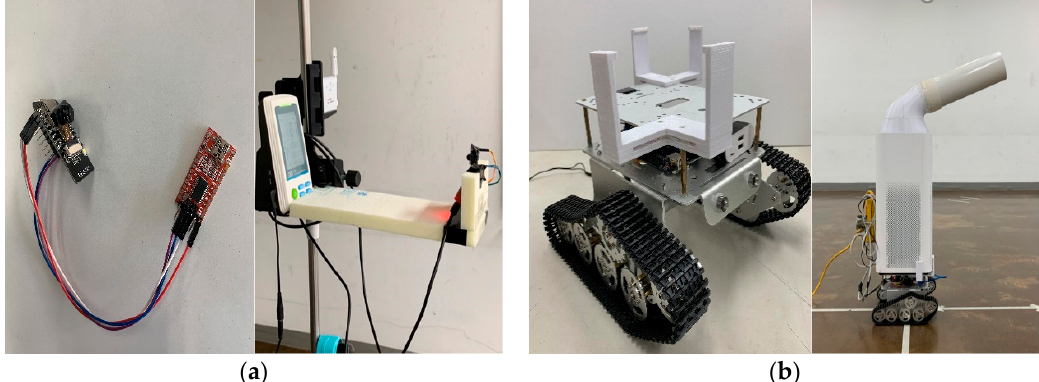
Figure 7. Data communication module and remote transfer unit used in the experiment: ( a ) Data communication module, ( b ) Remote transfer unit.